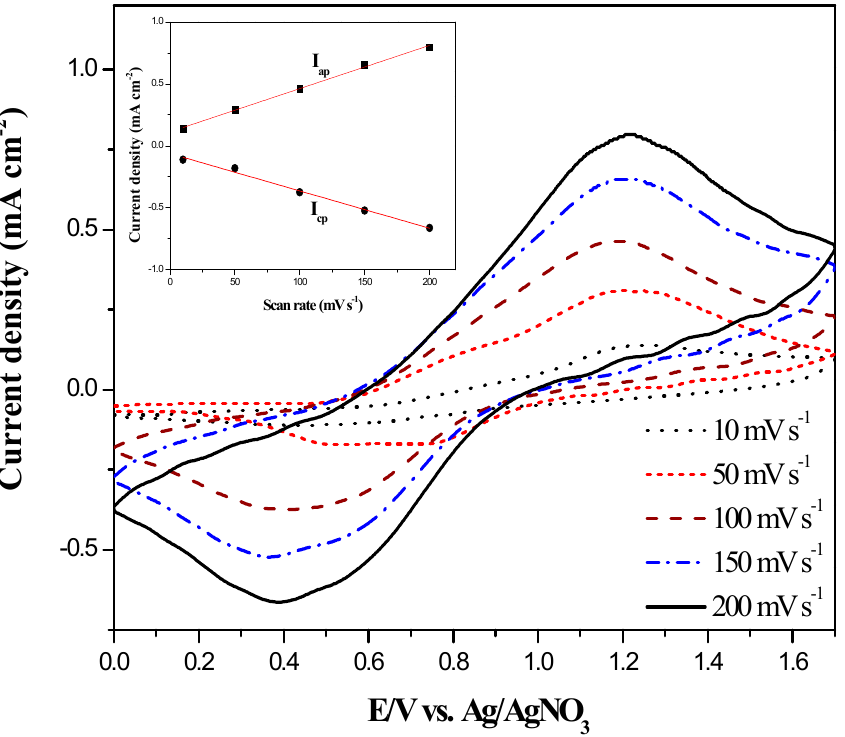
Figure 5. Cyclic voltammetry (CV) curves of the P(BCz- co -ProDOT) film at different scan rates between 10 and 200 mV ∙ s − 1 in a PC/ACN (1:1, by volume) solution containing 0.2 M LiClO 4 . The inset is scan rate dependence of the P(BCz- co -ProDOT) anodic and cathodic peak current densities, respectively.